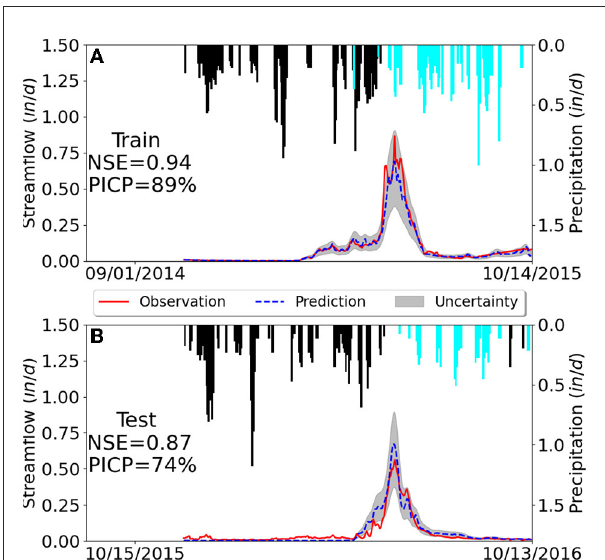
FIGURE2 Predicted (dashed blue line) and observed streamflow (solid red line) in the snow-dominant Quigley catchment where the gray area quantifies the 90% predictive interval. Daily precipitation is plotted upside down on the top associated with the right y-axis, where snow (temperature below 0 ◦ C and in snow-water equivalents) is highlighted in black. Subfigures (A, B) illustrate the results from training and test data sets, respectively.